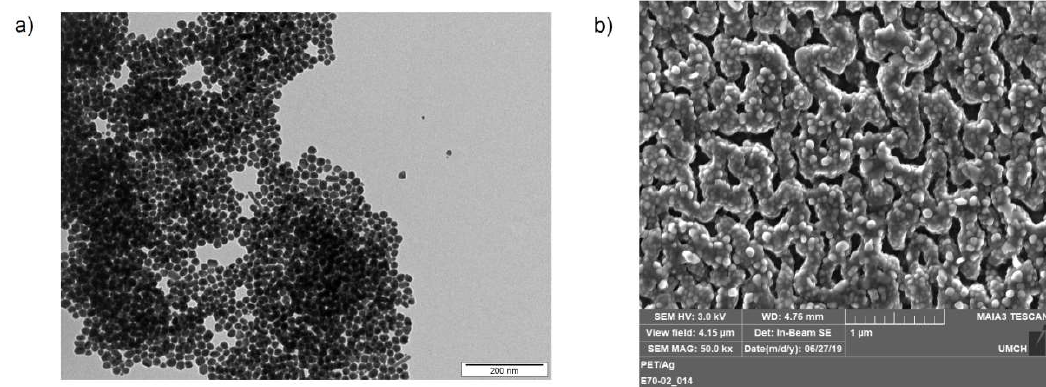
Figure 8. Images of electrochemically synthetized AgNPs ( a ) and AgNPs immobilized onto polyethyleneterephthalate surface by KrF excimer laser ( b ), measured by transmission and scanning electron microscopy, respectively.